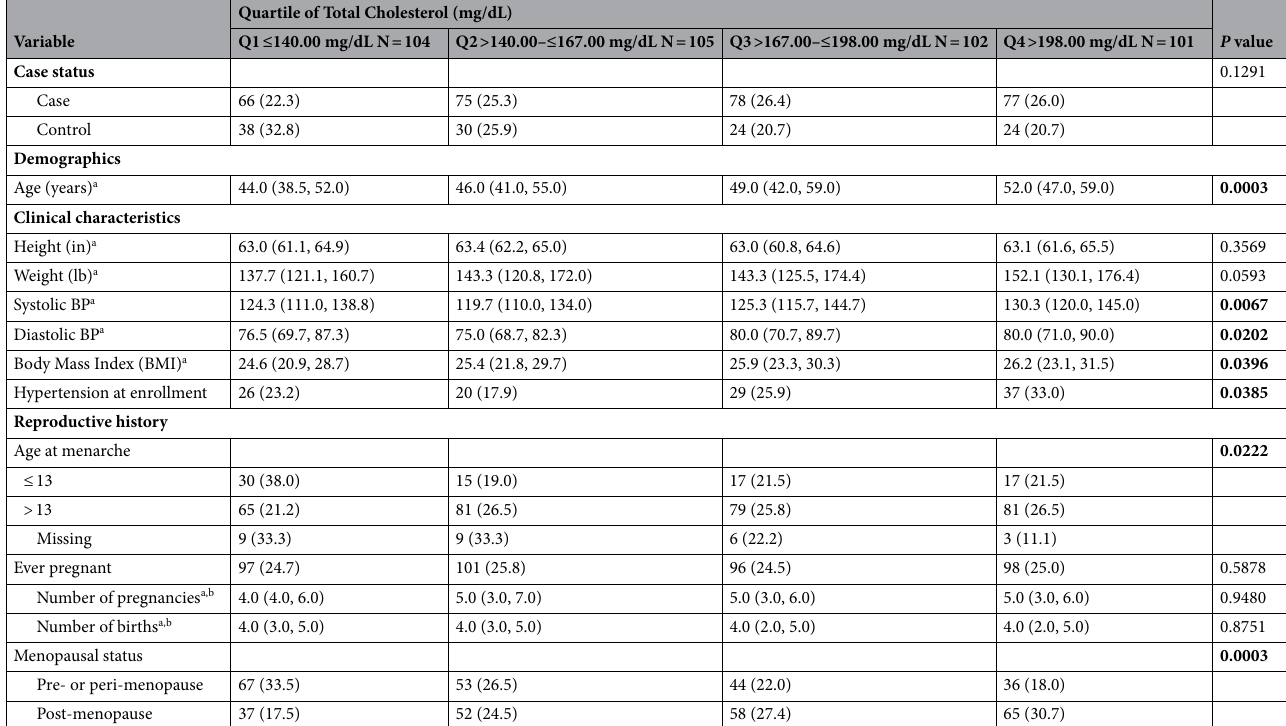
Table 2. Clinical and reproductive characteristics of MEND cases and controls by quartile of total cholesterol. a Median (Q1, Q3). b Among those who were ever pregnant. Where applicable, missing values were not used to compute